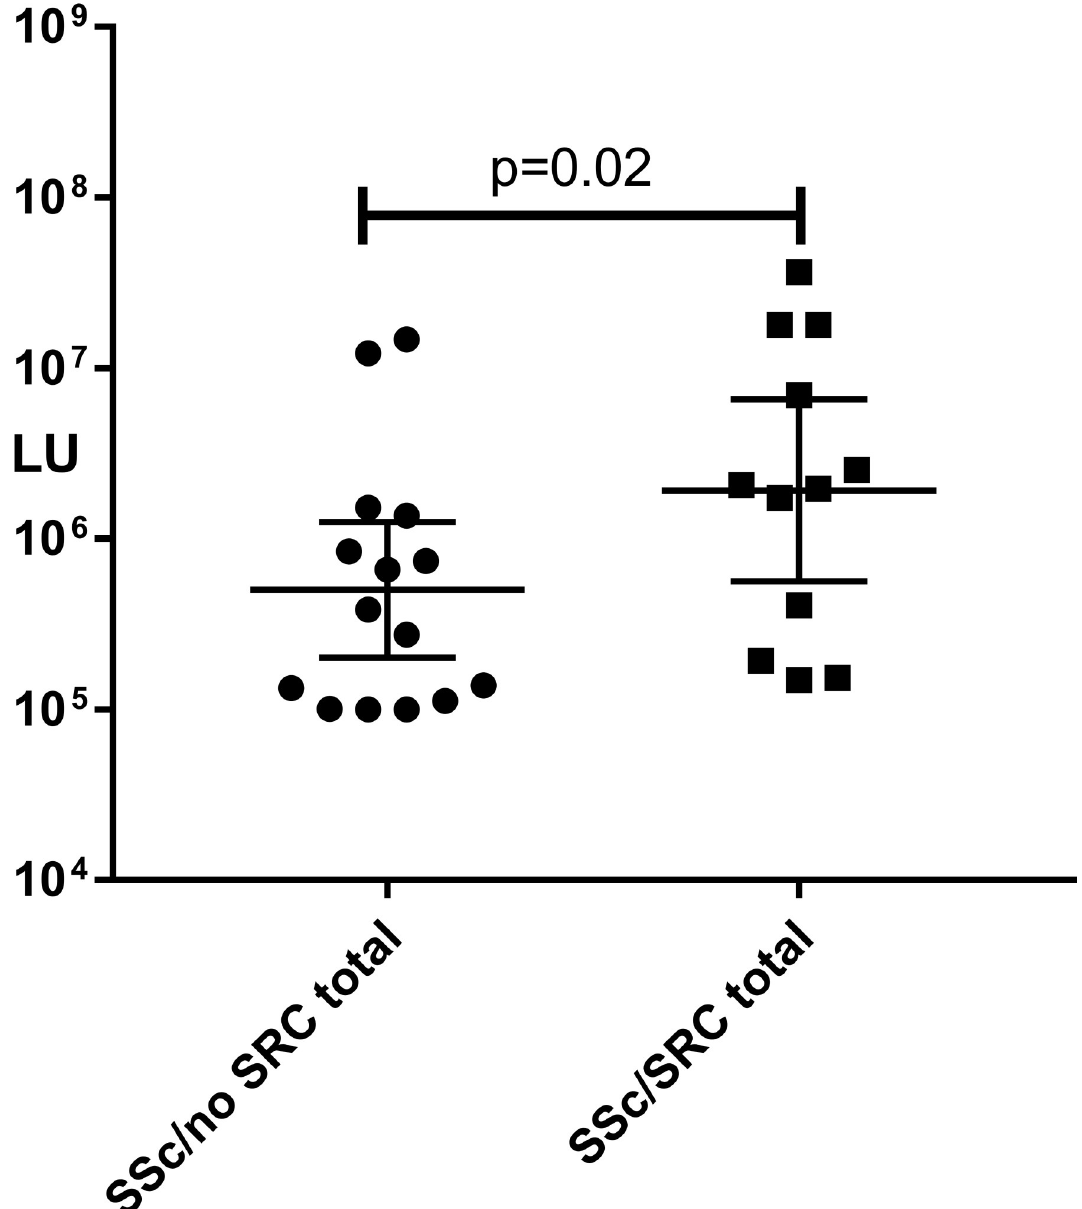
Fig 6. Higher autoantibody levels in SSc/SCR compared to SSc/no SRC cases. The scatter plot graphs represent the total antibody response in individual seropositive SSc/SRC and SSc/no SRC cases. This analysis was accomplished by summing up the autoantibody values against the twelve autoantigens from the last time point of the seropositive subjects. The P values were calculated using the Mann-Whitney U test.